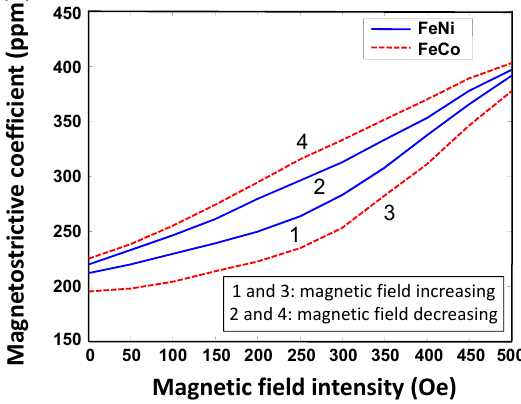
Figure 12. The measured magnetostrictive curves for FeCo and FeNi.